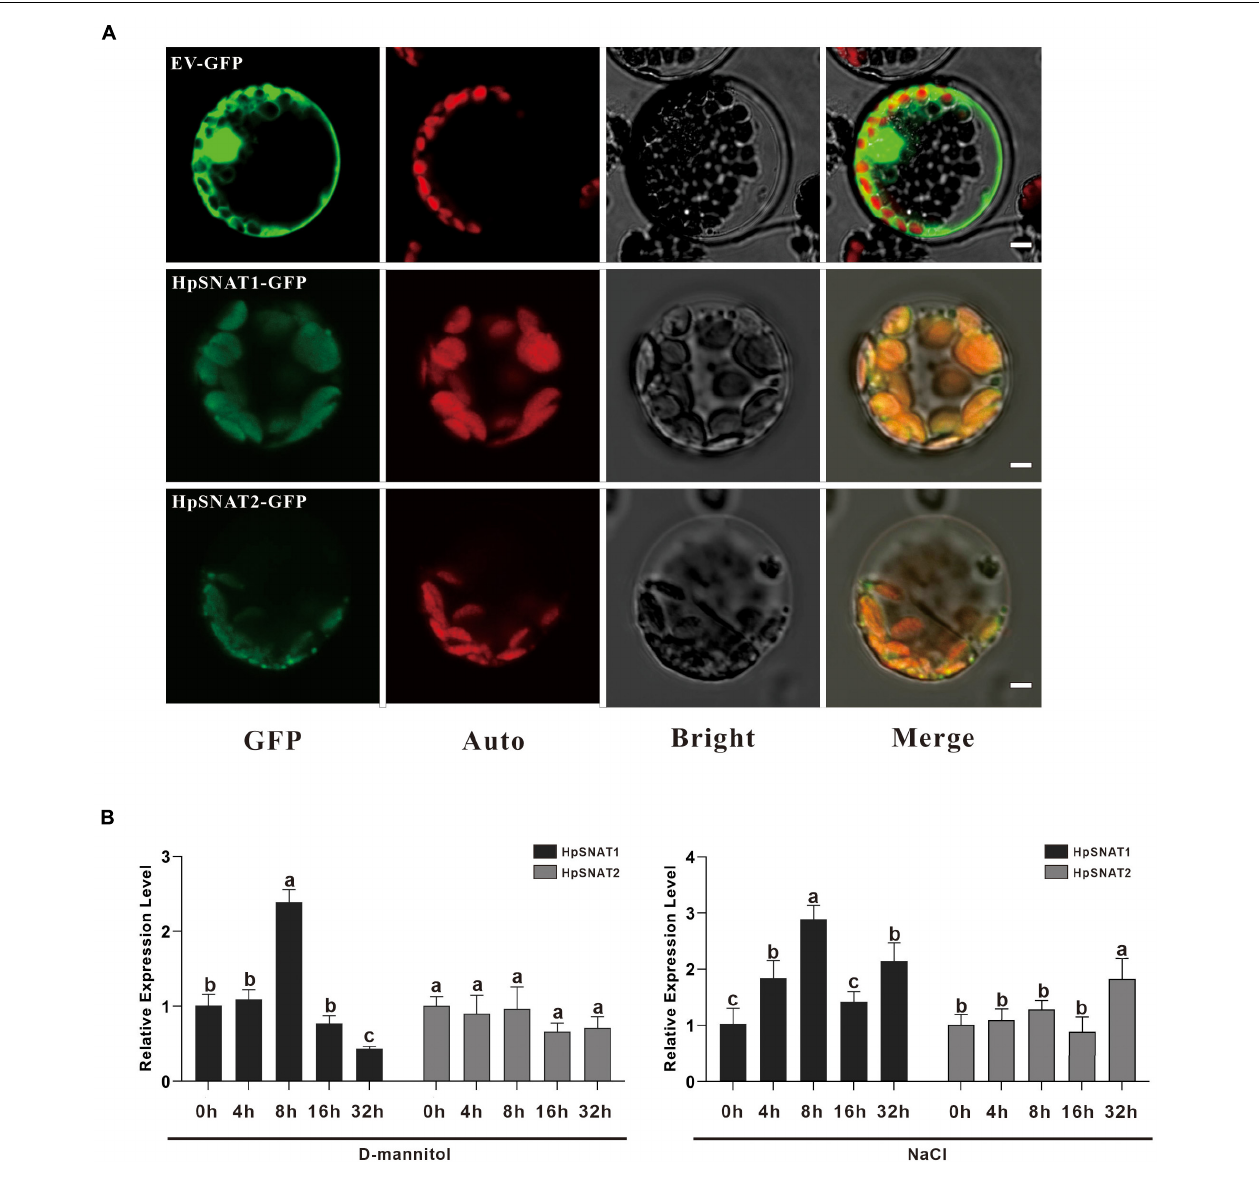
FIGURE 2 | Subcellular localization and expression patterns of HpSNAT. (A) From left to right are the subcellular localization of the target genes (GFP), chloroplast autofluorescence (Auto), bright-field (Bright), and Merged (Merge) images. Scale bars = 5 µ m. (B) Relative quantitative analysis of HpSNAT1 and HpSNAT2 under drought (D-mannitol) and high-salt (NaCl) stress conditions. Data were normalized by HpACT2 (MK054303), calculated with the equation 2 −(cid:52)(cid:52) Ct . All data represent averages of three biological replicates, error bars indicate ± SD. Different letters indicate significant differences from the control ( P < 0.05) tested by one-way